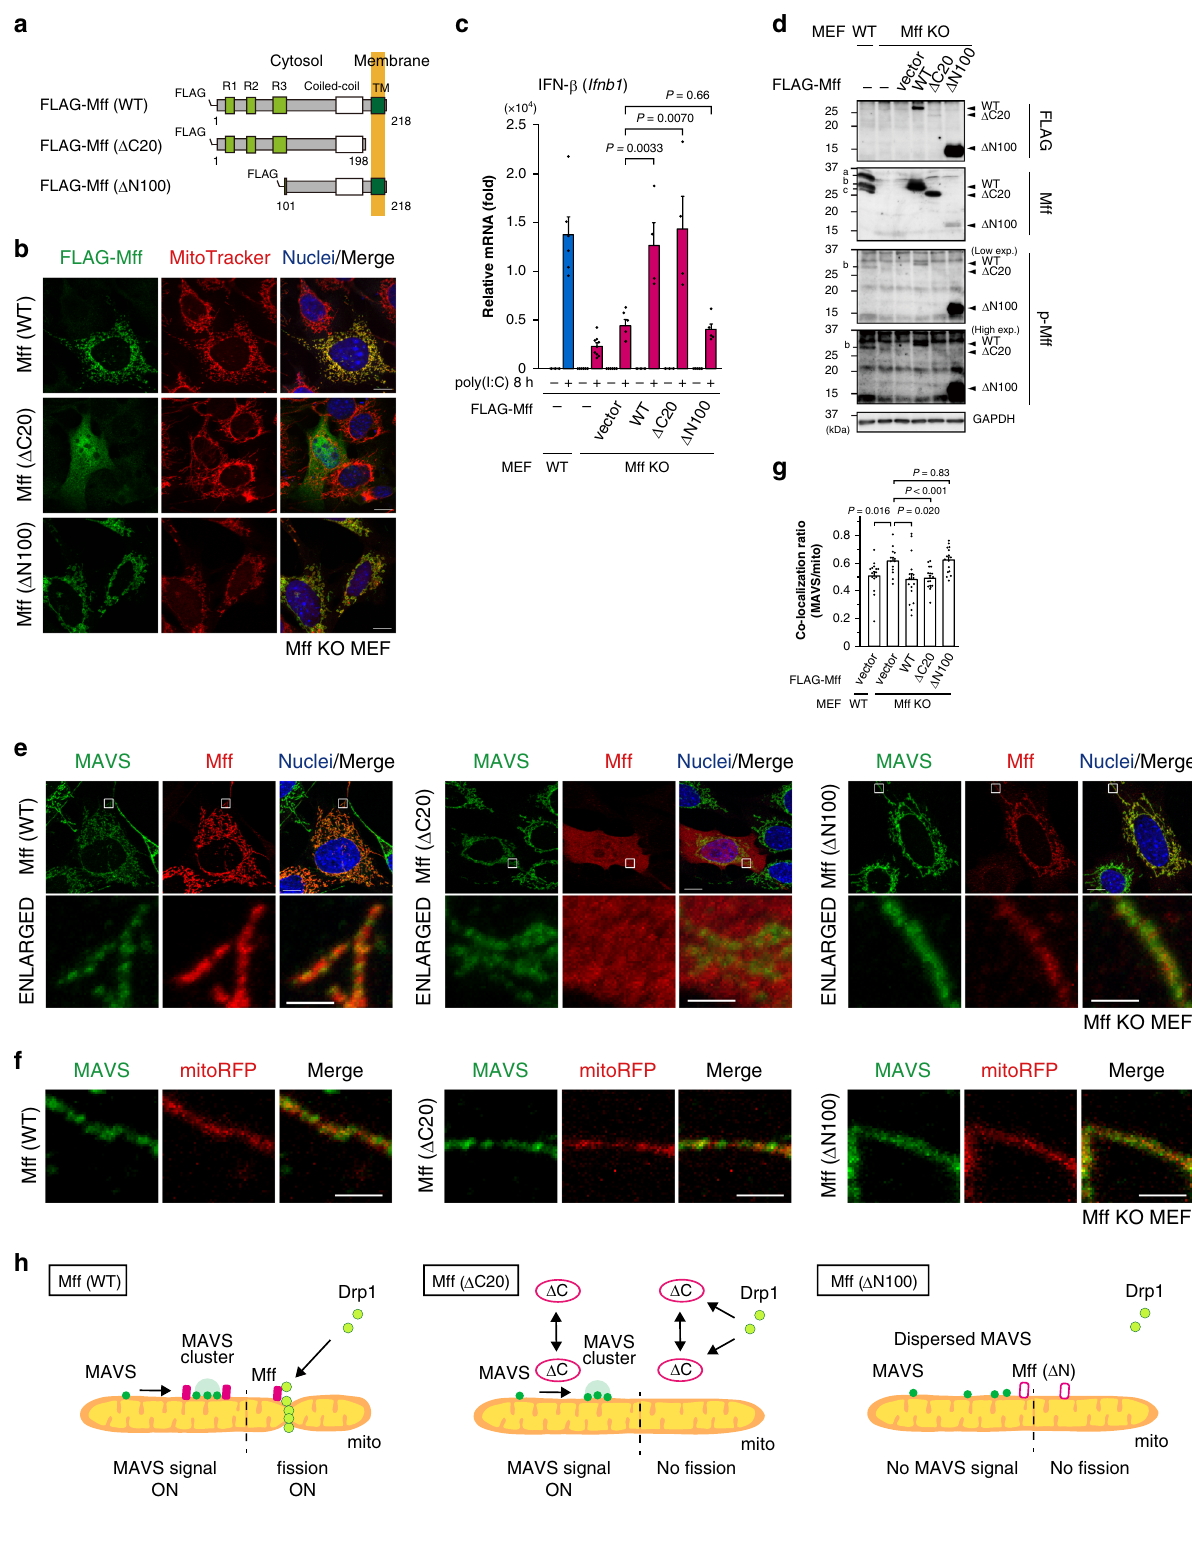
(Fig. 5a, b). We found that the phosphorylation-mimic mutant cluster formation (images in Fig. 5f, quanti fi cation in Fig. 5g). In S146D migrated slower than the phosphorylation-negative contrast, S146D rather inhibited cytokine induction (Fig. 5c, d), mutant S146A in sodium dodecyl sulfate (SDS)-PAGE, similar which induced mitochondrial fi ssion (Fig. 5e), without inducing to phosphorylated and non-phosphorylated Mff (WT), respec- MAVS cluster formation (Fig. 5f, g). Unexpectedly, stably tively (Fig. 5b). Under the infectious condition, S146A rescued expressed Mff (WT) failed to activate the cytokine induction cytokine induction in Mff KO MEFs (Fig. 5c, d), without inducing (Supplementary Fig. 4e, f), different from those of transiently apparent mitochondrial fi ssion (Fig. 5e), but it induced MAVS expressed Mff (WT) that rescued antiviral response in Mff KO NATURE COMMUNICATIONS| (2020) 11:5711